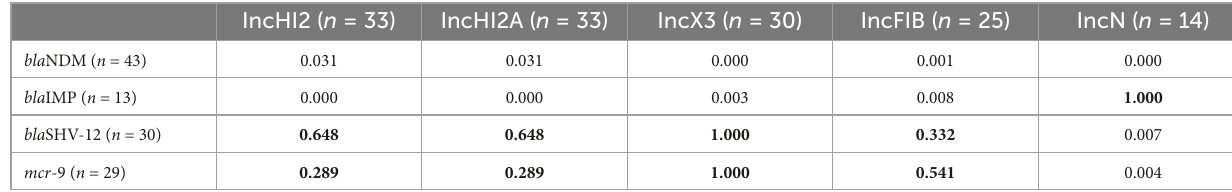
TABLE 1 Distribution of plasmid replicons and antimicrobial resistance genes in the 51 carbapenem-resistant Enterobacter cloacae complex (CREC) isolates.